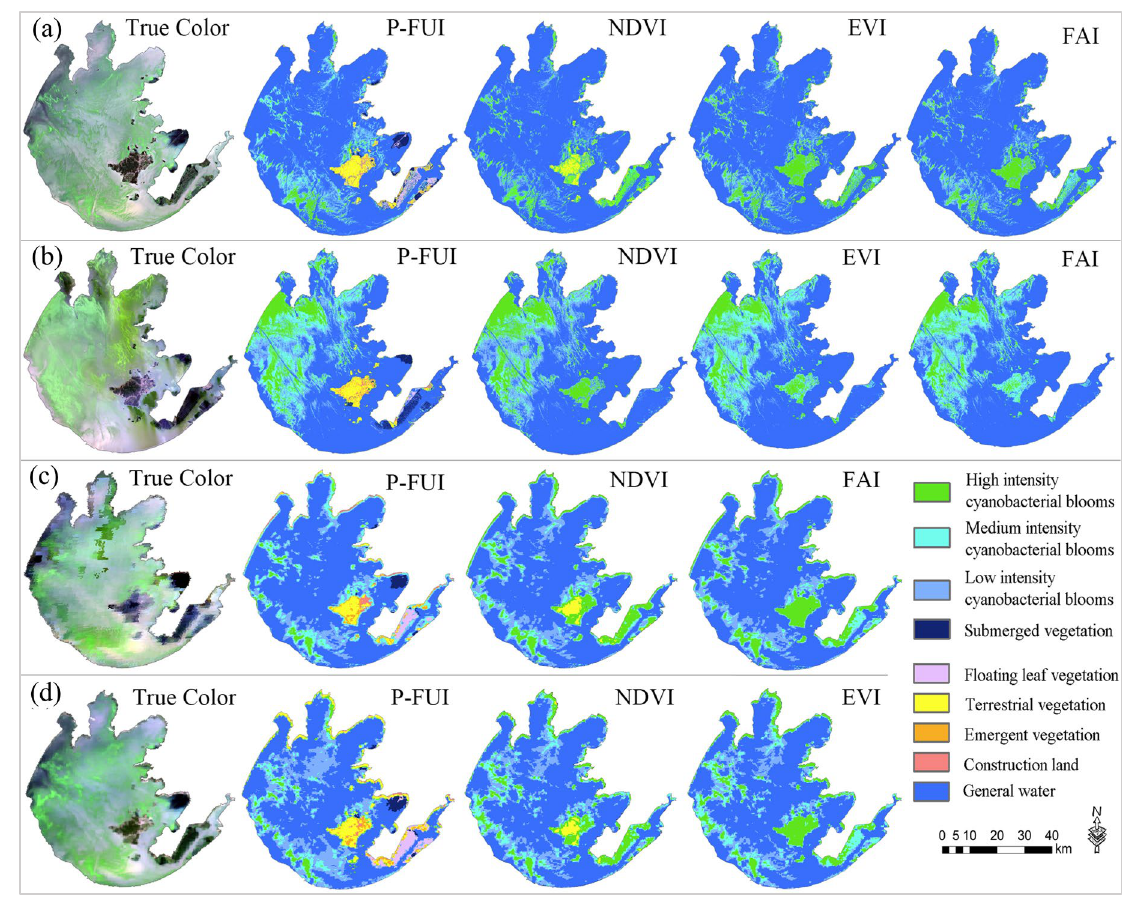
Figure 10. Comparison between ( a ) MSI, ( b ) OLI, ( c ) MODIS, and ( d ) OLCI images of Lake Taihu in identifying surface features under various indexes. The images of MSI, OLI, and MODIS sensors were sensed on 17 August 2019, while the images of the OLCI sensor were sensed on 11 May 2017. Table 4. Quantitative evaluation of the CBs identification accuracy based on MODIS, OLI, MSI, and OLCI